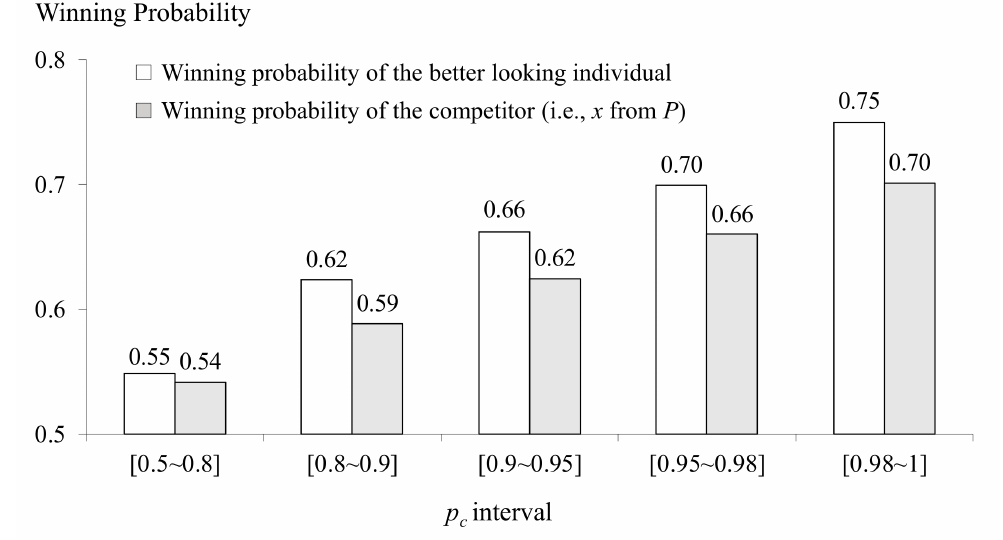
Figure 8. The winning probabilities of chosen individuals at different values of p c during the search for an optimal solution of the Ackley function ( σ = 0.1) by